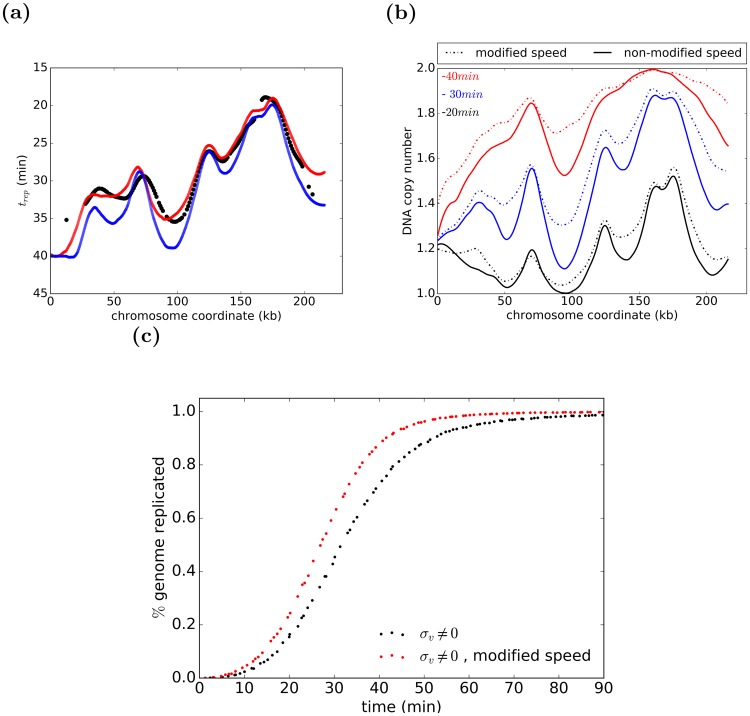
Replication timing profile and DNA copy number of chromosome I and percentage of genome replicated as a function of time.(a) Schematic representation of replication timing profile for experimental data ([23]) (black), along with modified (red) and non-modified (blue) fork speed models, which shows a better fit of the experimental data with modified fork speed model. (b) DNA copy number at different time points for both modified and non-modified speed models. (c) The impact of the fork speed modifications on the dynamics and completion of replication. The percent of replicated genome is presented as a function of time for stochastic forks’ speeds models with regular (black) speed and speed modified based on the distance to approaching fork (red). The modified forks’ speeds model promotes timely completion of the replication.